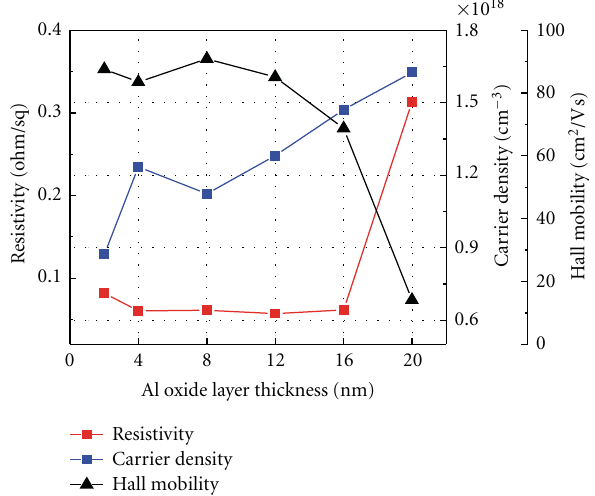
Figure 10: Resistivity, Hall mobility, and carrier density of the pc-Si films as a function of di ff erence Al oxide layer